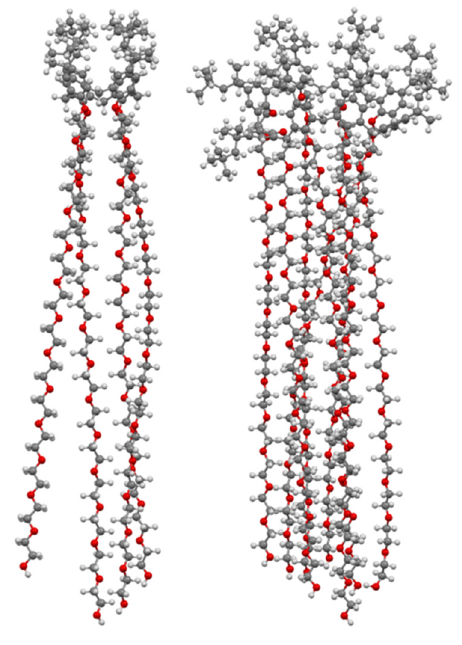
Figure 1. Macrocyclon as originally envisaged by Cornforth ( left ) and as later determined ( right ).